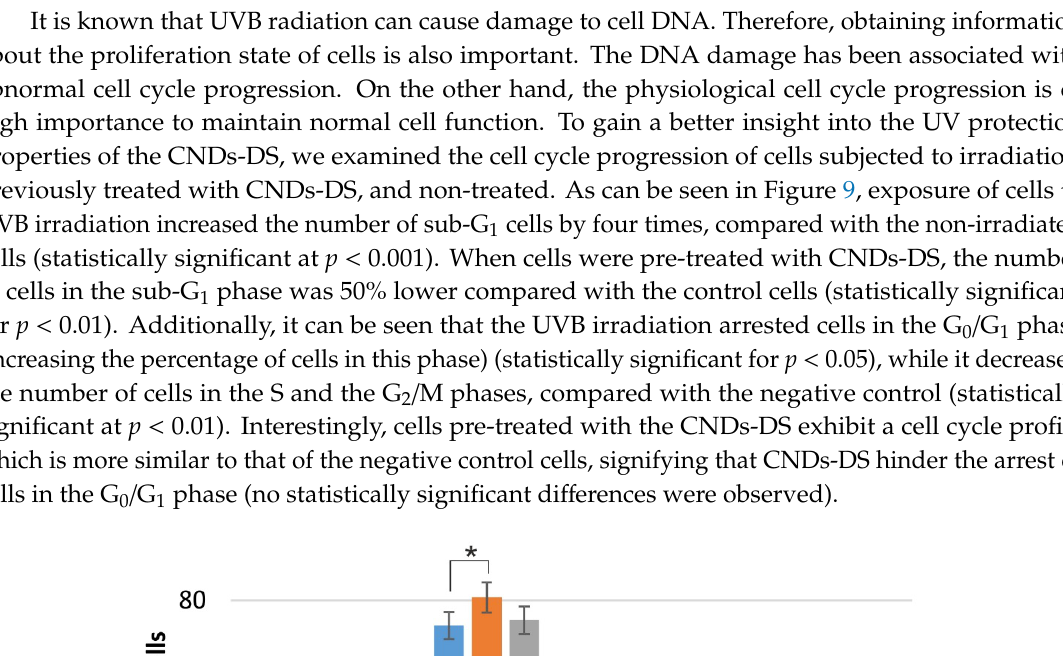
Figure 8. % Viability of HaCaT cells: (1) negative control (cells not irradiated), (2) control (irradiated cells, without CNDs-DS), (3) cells pre-treated with 100 μg mL −1 CNDs-DS, and (4) cells pre-treated with 200 μg mL −1 CNDs-DS. The samples treated with the CNDs were found to be statistically different from the control sample at p < 0.001 (***).